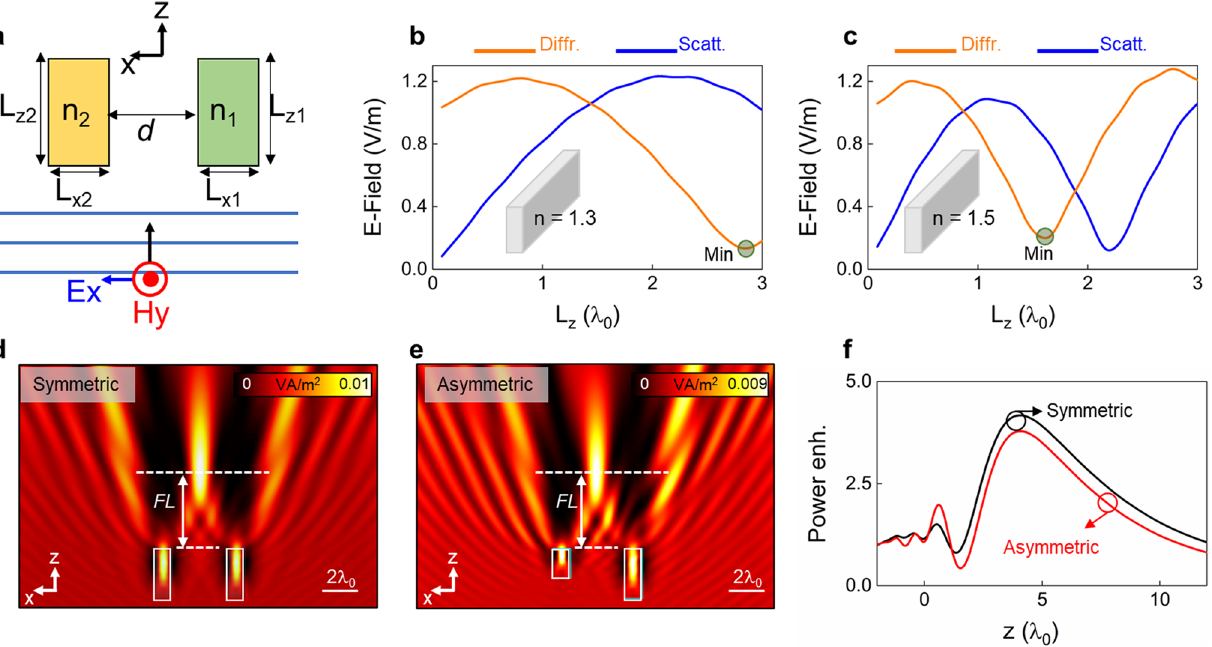
Figure 1. ( a ) Schematic representation of the proposed dual-dielectric configuration to generate a photonic hook when illuminated with a planewave. Note that the position z = 0 is located at the output surface of the two dielectrics (see x- and z- axes in this panel). ( b , c ) numerical results of the scattered (blue lines) and diffracted (orange lines) field distributions generated by a single dielectric particle immersed in free-space calculated at a distance z = 4 λ 0 from the output surface of the dielectric with lateral dimension L x = λ 0 and variable L z . In these results we consider dielectric particles having a refractive index of n = 1.3 ( b ) and n = 1.5 ( c ). ( d ) Power distribution on the xz plane of a dual-dielectric structure with the same dimensions and refractive index (i.e., symmetric case with n 1 = n 2 = 1.3 and L z1 = L z2 = 2.83 λ 0 , these values correspond to the minimum scattered field as shown in panel ( b )). ( e ) Power distribution on the xz plane of a dual-dielectric structure with different dimensions and refractive index (i.e., asymmetric configuration with n 1 = 1.3 and L z1 = 2.83 λ 0 and n 2 = 1.5 and L z2 = 1.67 λ 0 , again these values correspond to the minimum scattered field as shown in panels ( b , c ) respectively). ( f ) Power enhancement along the propagation z- axis calculated at x = y = 0 for the symmetric (black) and asymmetric (red) dual-dielectric configurations shown in ( d , e ) respectively. Panel ( a ) was created using Microsoft PowerPoint version